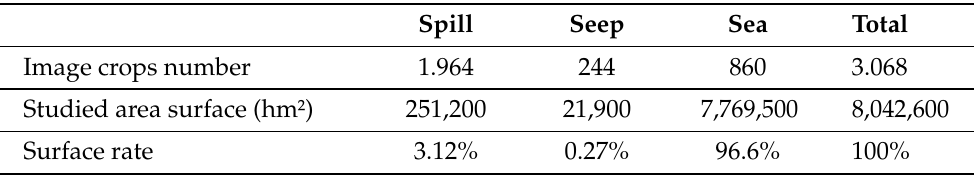
Table 3. Statistics of the training and validation dataset consisting of crops with a size of 512 × 512